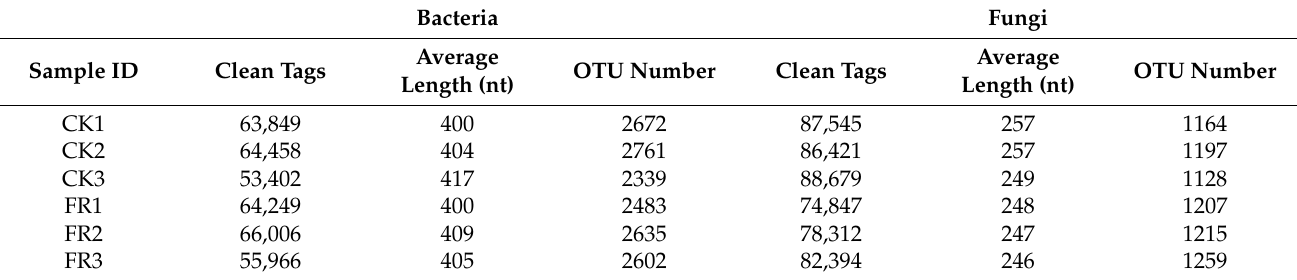
Table 5. Bacterial and fungal metabarcoding sequencing